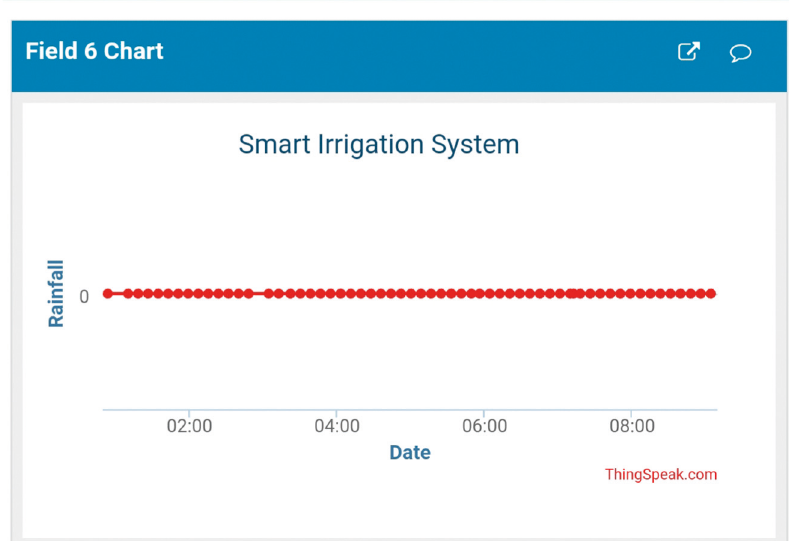
Figure 14: Rainfall.